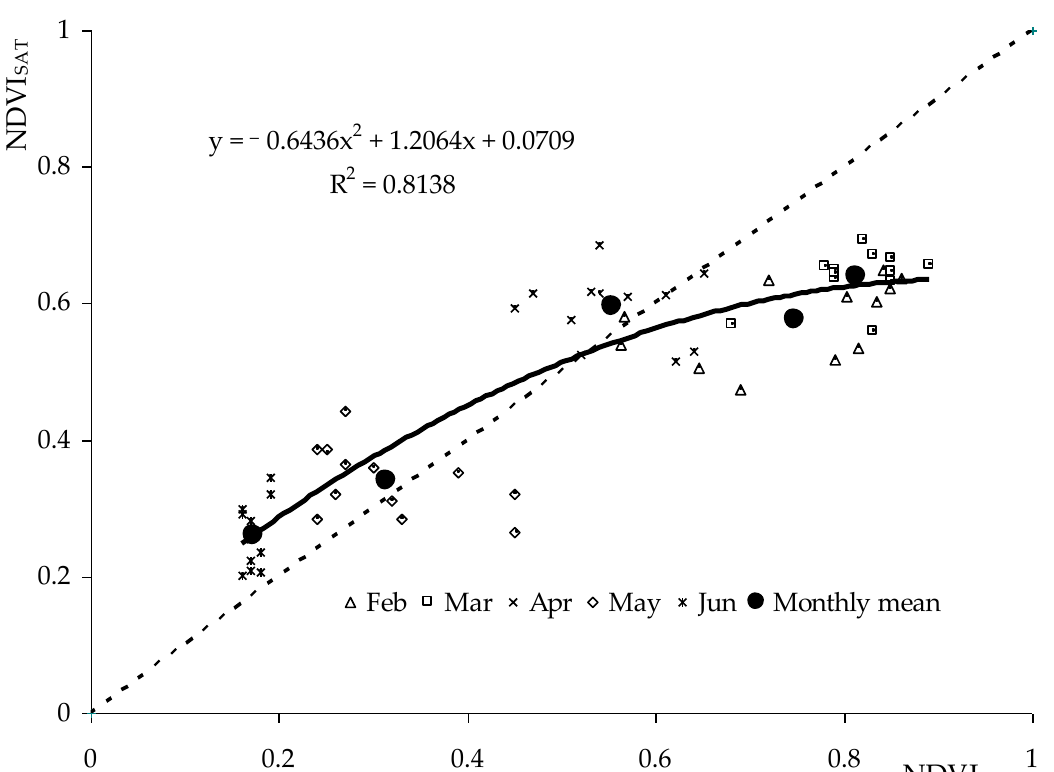
y = _ 0.6436x 2 + 1.2064x + 0.0709 R 2 = 0.8138